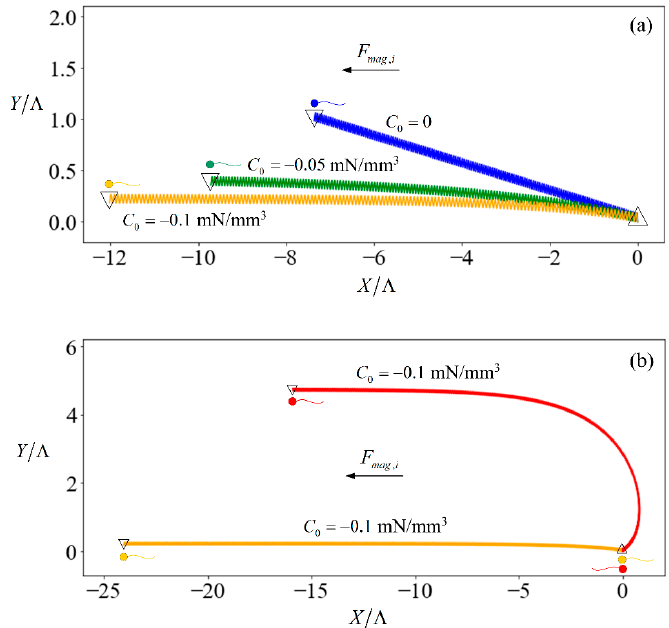
Figure 2. ( a ) Trajectory of spermatozoa, initially heading in the negative x -direction, subjected to C 0 = − 0.1 mN/mm 3 (orange line), − 0.05 mN/mm 3 (green line), and 0 (blue line) over 10 s; ( b ) trajectory of spermatozoa, initially heading in the negative (orange) or positive (red line) x -direction, subjected to C 0 = − 0.1 mN/mm 3 for 20 s. In both plots, the upward-pointing triangles denote the starting position